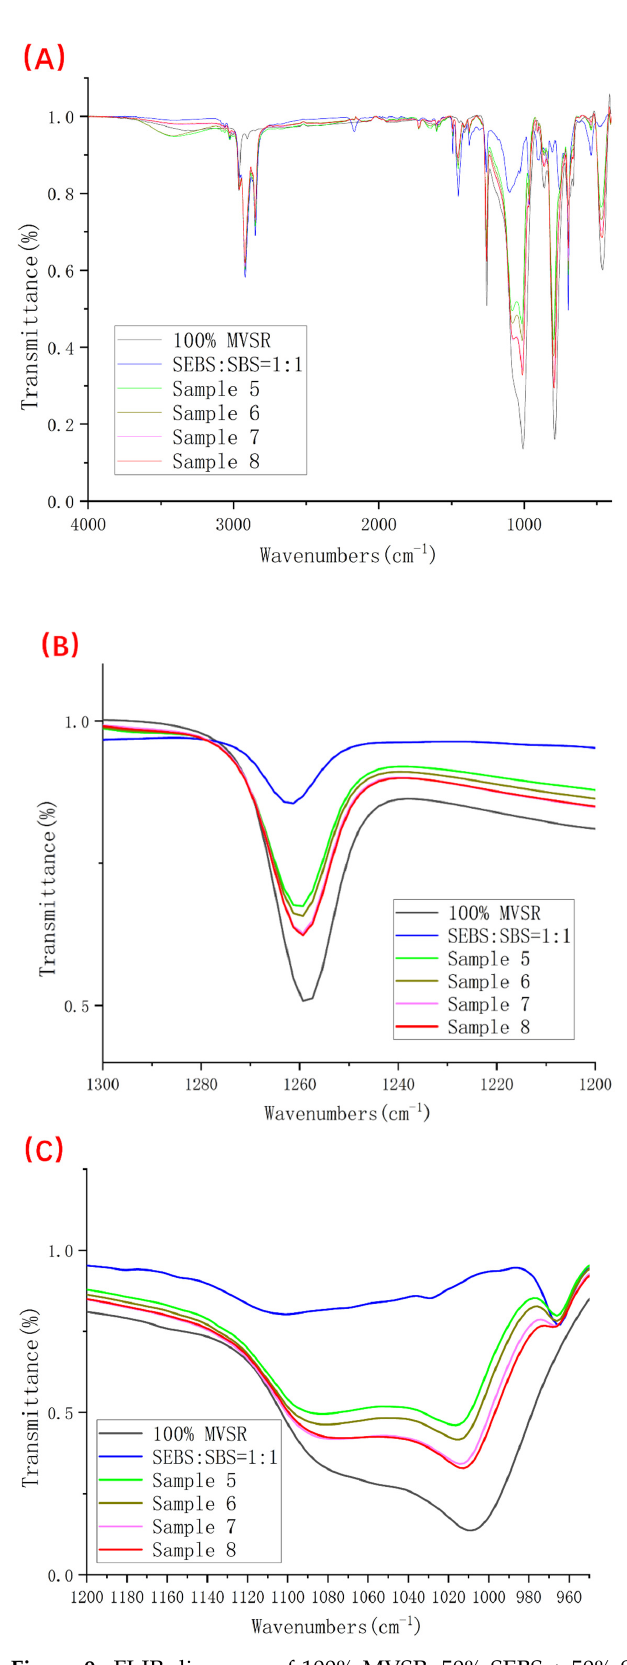
Figure 9. FI-IR diagrams of 100% MVSR, 50% SEBS + 50% SBS and samples 5–8. ( A ) Complete spectrum; ( B ) Enlarged detail near wavenumber 1260 cm − 1 ; ( C ) Enlarged detail near wavenumber 1010 cm − 1 . Table 3. Peak wave numbers of FI-IR diagrams of 100% MVSR, 50% SEBS + 50% SBS and samples 1–8.